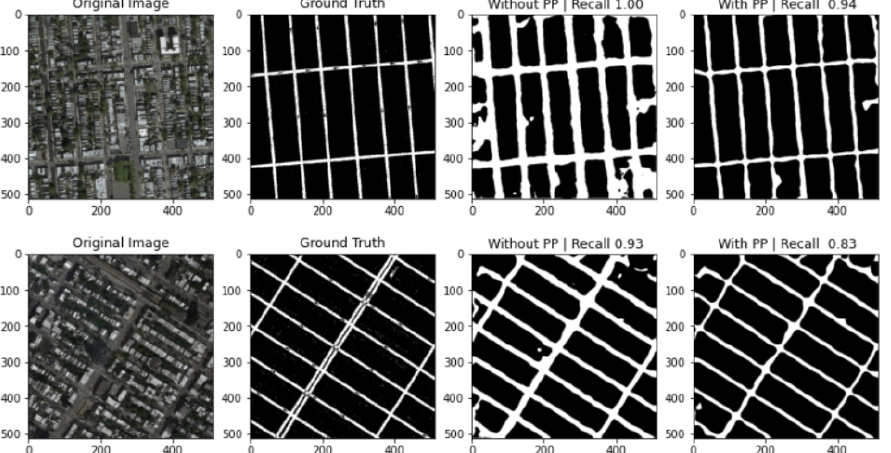
Figure 11. Some example predictions from Pix2Pix datasets with and without post-processing pipeline along with recall